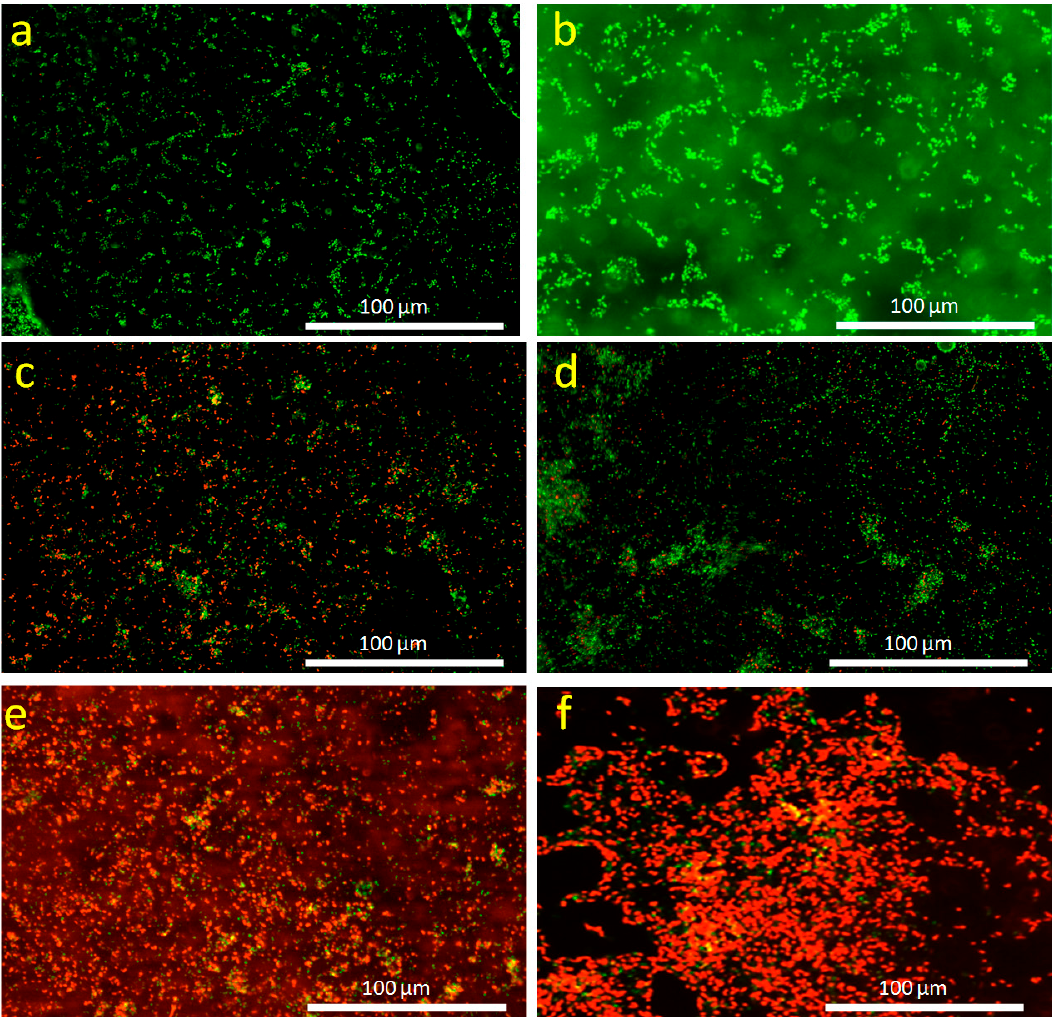
Figure 10. Fluorescence images of E. coli stained using the LIVE/DEAD Bac Light bacterial viability kit. ( a , b ) Control and incubated with CuS-BSA/lysozyme nanoparticles (100 µ g mL − 1 ) ( c , d ) without and ( e , f ) under 980 nm (1 W cm − 2 ) irradiation. Note: Green color indicates viable bacteria and red color corresponds to dead